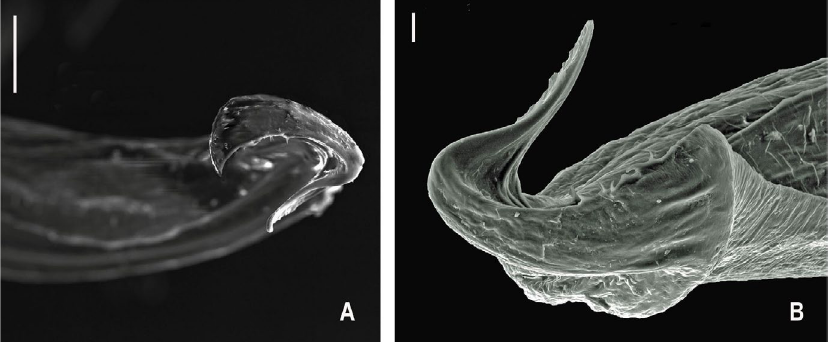
Fig. 11. Levizonus thaumasius Attems, 1898, ♂♂ (FSCB 12016). A–B . Gonopod apex, ventral view. Scale bars: A = 100 μm; B = 20